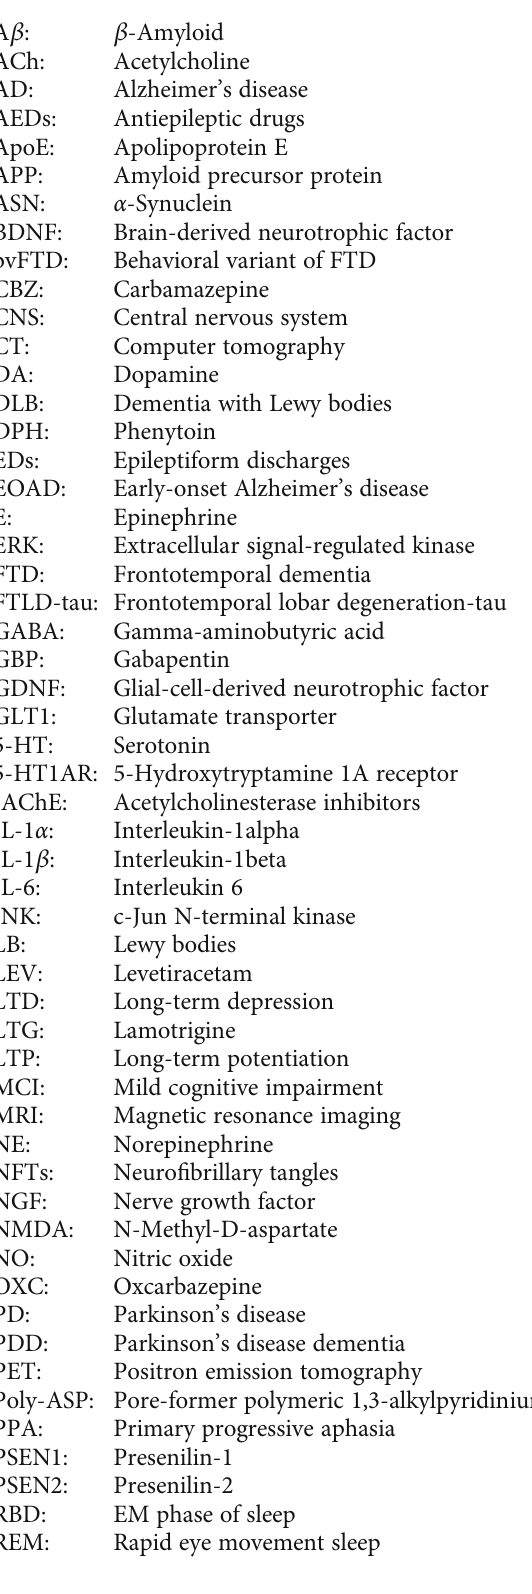
number of individuals a ff ected by neurodegenerative